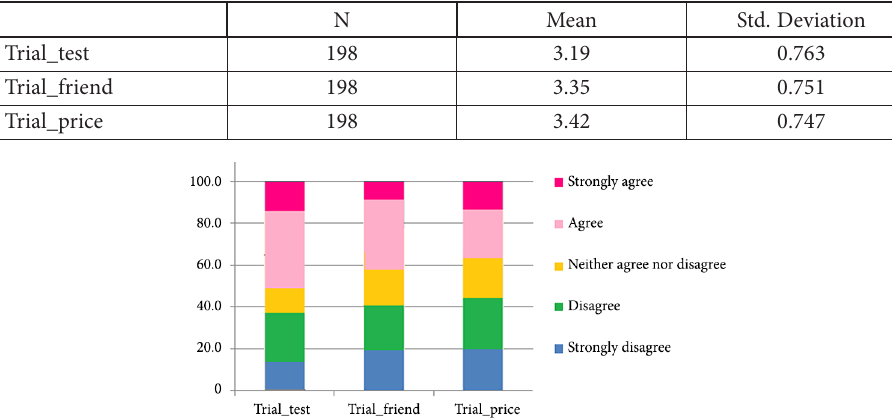
Figure 11. Respondents’ viewpoints regarding the variable